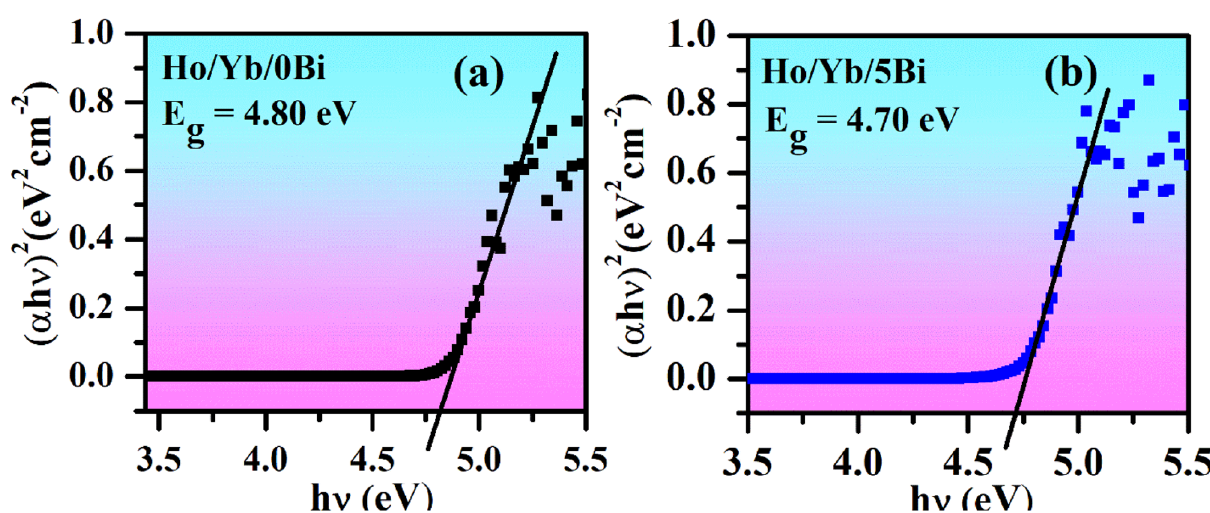
Figure 6. The plots between hν ~ (αhν) 2 for the (a) Ho 3+ /Yb 3+ /0Bi 3+ and (b) Ho 3+ /Yb 3+ /5Bi 3+ co-doped phosphor